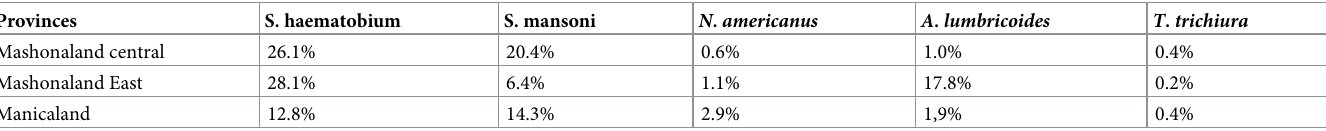
Table 1. Prevalence of S . haematobium , S . mansoni , T . trichiura , N . americanus and A . lumbricoides in Mashonaland Central, Mashonaland East and Manicaland in 2011.